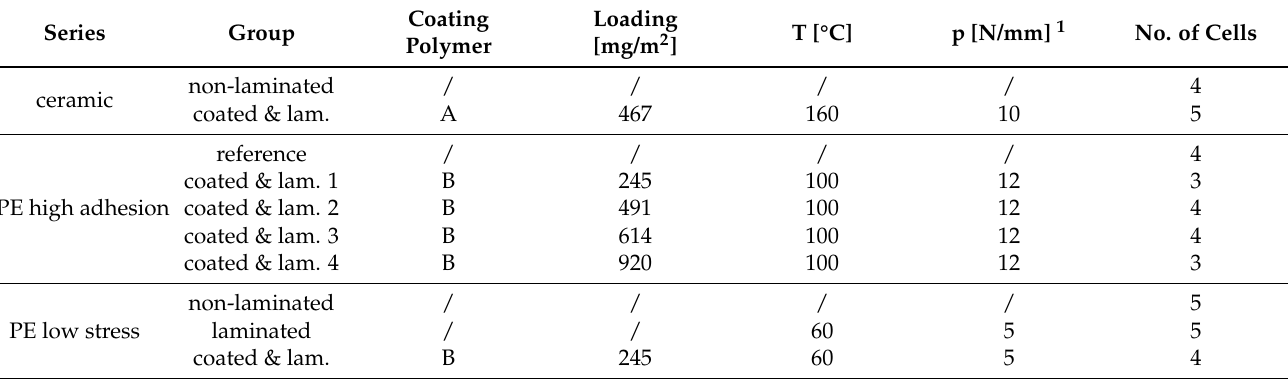
Table A1. Overview of investigated pouch